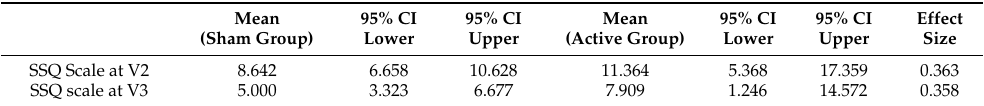
Table 2. Simulator Sickness Questionnaire (SSQ) scores at V2 and V3.